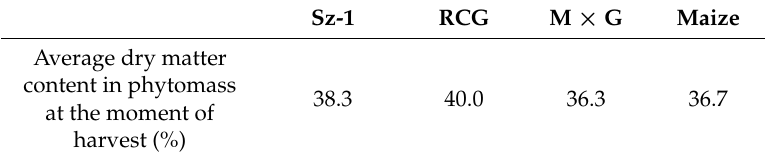
Table 13. Average dry matter content in phytomass at the moment of harvest